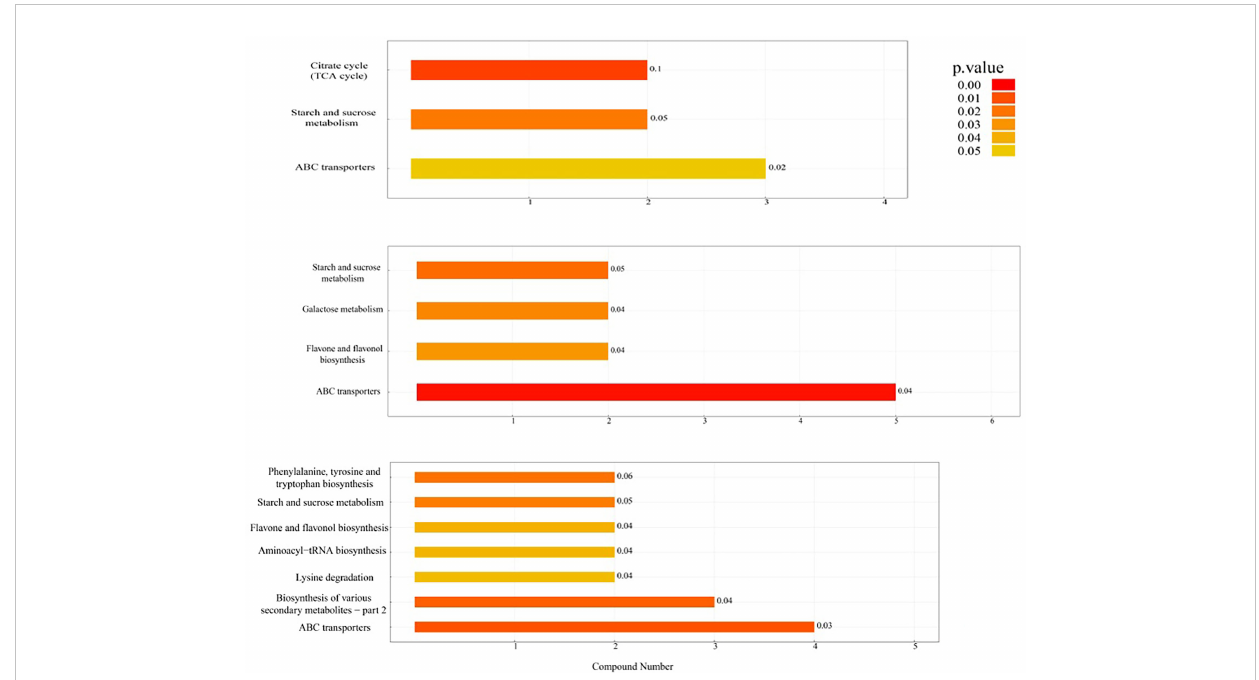
FIGURE 4 Histogram of KEGG enrichment pathway analysis. The vertical axis in the fi gure represents each KEGG metabolic pathway, and the horizontal axis represents the number of differentially expressed metabolites contained in each KEGG metabolic pathway. Color represents the average p value of enrichment analysis. The darker the color is, the smaller the average p value and the more signi fi cant the enrichment degree.